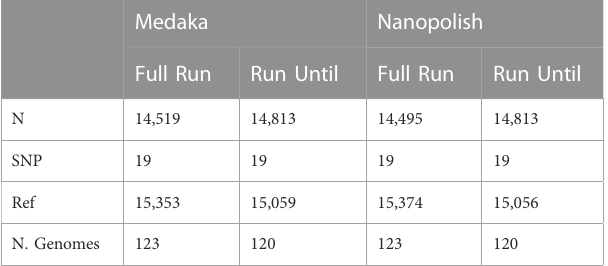
Figure S2B. Unexpectedly, even given the 1200bp read lengths, this resulted in the ability to detect 16 more amplicons at 50× coverage on the less abundant barcodes, compared with the control run after 110 min of sequencing, as shown in Supplementary Table S2.